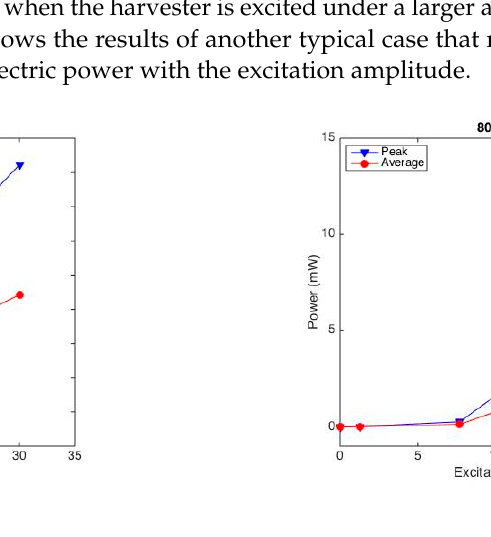
Figure 9. Normalized-harvested powers by varying excitation amplitudes for PPA. ( a ) under 100 Hz excitation; ( b ) under 80 Hz excitation.